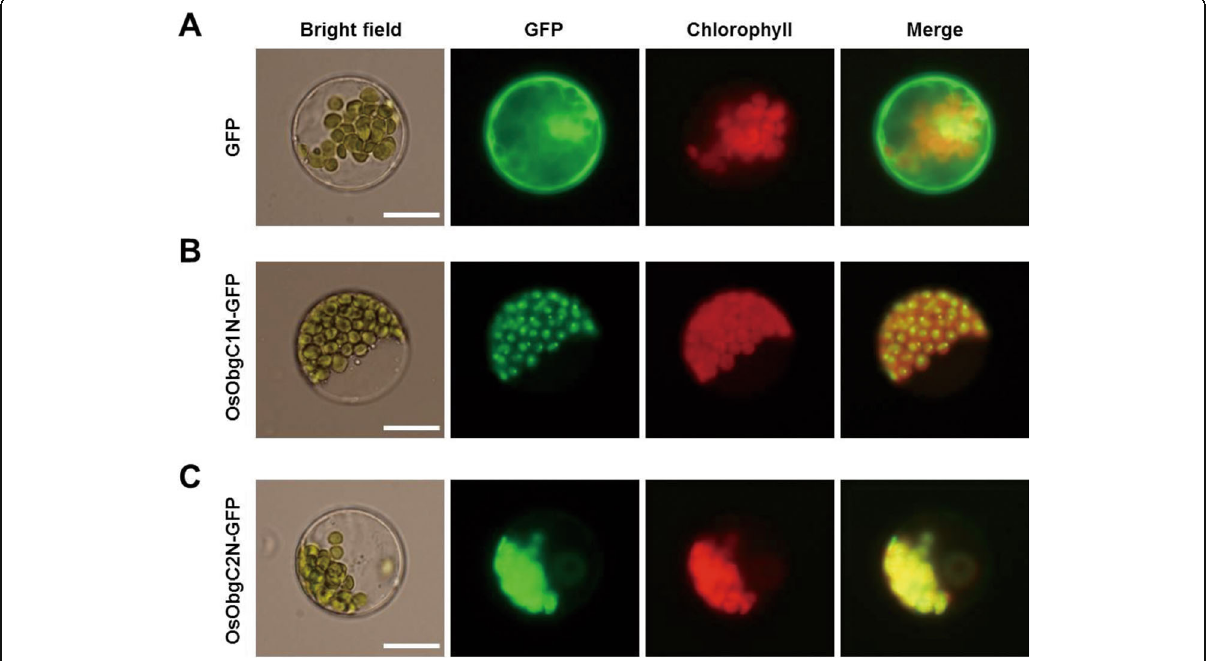
Fig. 1 Subcellular localization of rice Obg homologs. Arabidopsis protoplasts isolated from 2-week-old leaves were transformed with GFP ( A ), OsObgC1N-GFP ( B ) or OsObgC2N-GFP ( C ) and were observed with fluorescence microscopy 24 h after transformation. “ GFP ” represents green fluorescent protein in the transformed protoplasts. “ Merge ” displays the overlapped image of the GFP and the chlorophyll autofluorescence (Chlorophyll), which was used as a marker for chloroplasts. “ Bright ” is a bright-field image. White bars in the bright field images represent 20 μ m in